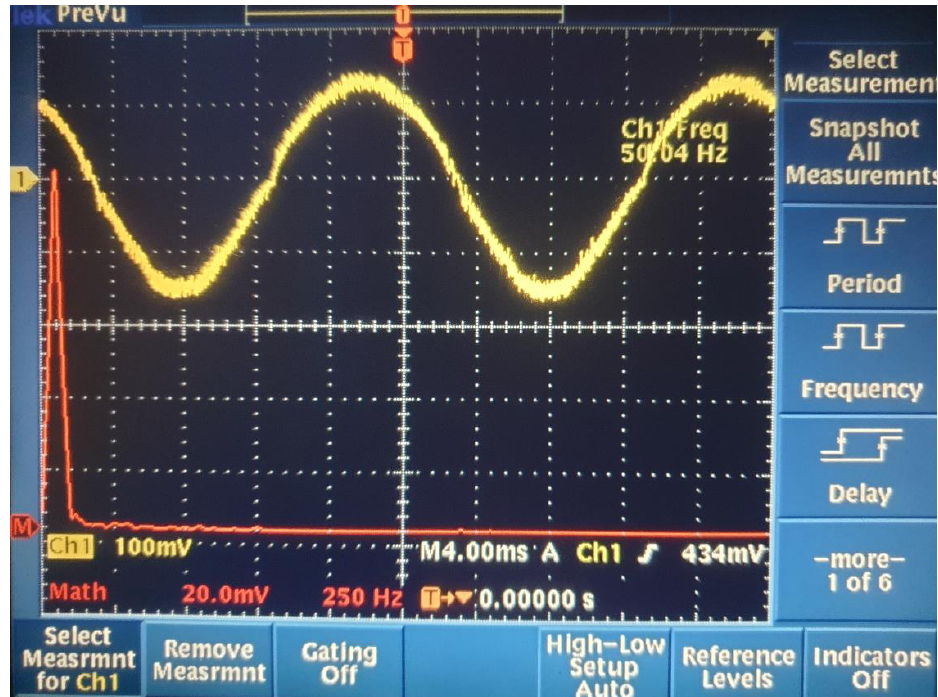
Figure 13. Waveform in phase a and respective FFT analysis of the prototype.